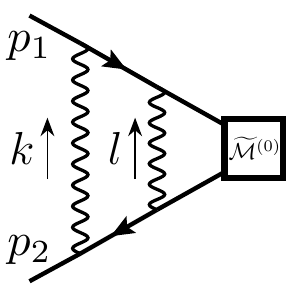
Figure 20. A sample graph that contributes to the second term on the right-hand side of eq. (5.37), using the same notation as eq.